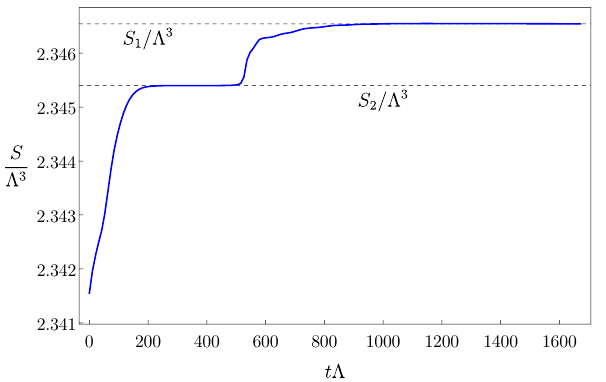
Figure 10 . Energy density (left) and longitudinal pressure (right) as a function of time at z Λ = 0 for the collision of figure 9.